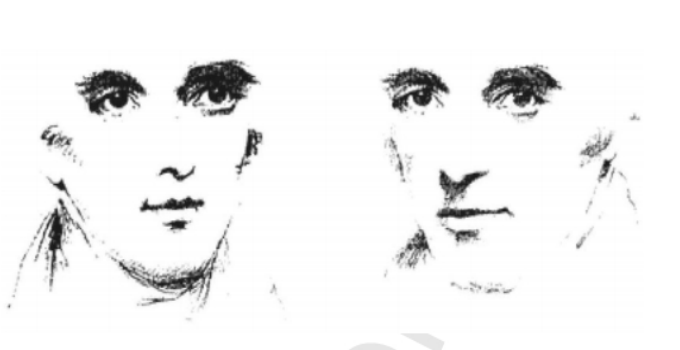
Figure 1. FIA and intrinsic relationship of face analysis tasks